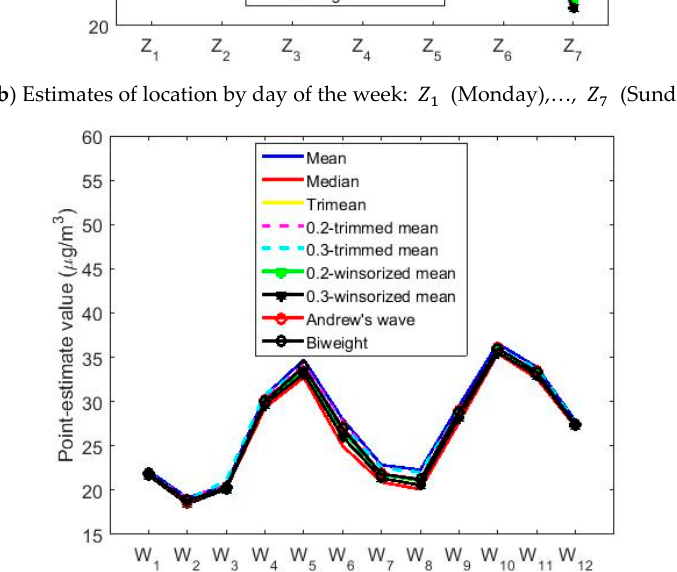
Figure 17. Estimates of location by month, day and hours.